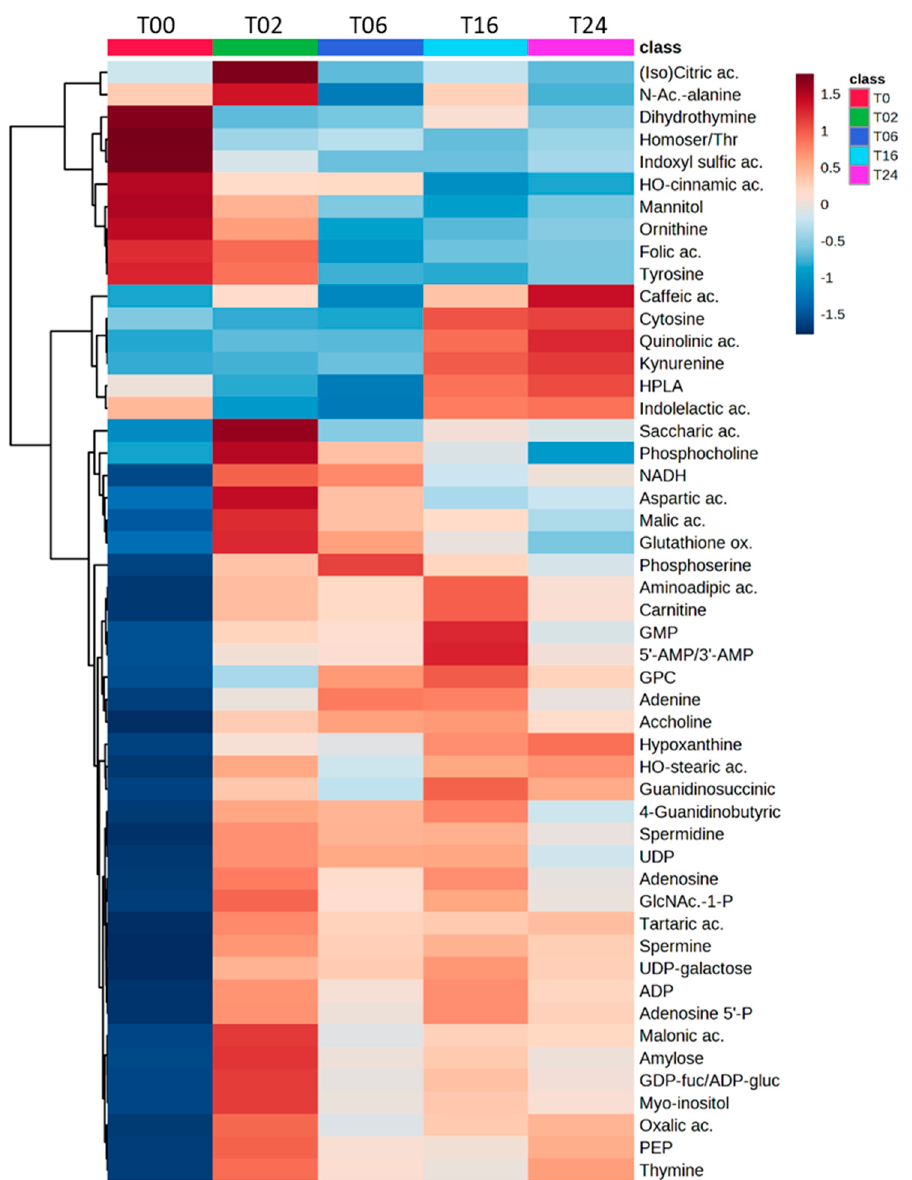
Figure 7. Heatmap showing the modulation of the top 50 impacted metabolites (according to ANOVA p -values) upon exposure of DCs to LPS. The heatmap depicted high (red) and low (blue) relative abundances (log-transformed, mean values are represented) of metabolites from HILIC( − ) and C18(+) datasets. Ac.: Acetyl; ac.: acid; ADP: Adenosine diphosphate; ADP − gluc: ADP-glucose; GDP: